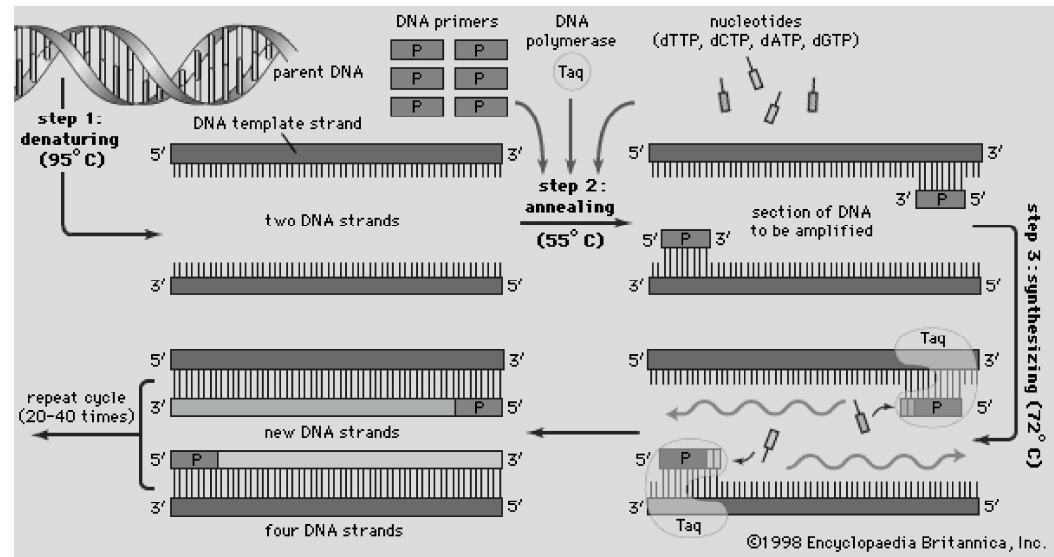
Figure 7. Schematic of the polymerase chain reaction, where a DNA sample is combined with DNA polymerase (Taq as in sample A of bottom image) and exposed to a thermal cycling profile which denatures, anneals DNA with a designated primer, and synthesis (amplification) of new DNA strands. Accessed online [81]